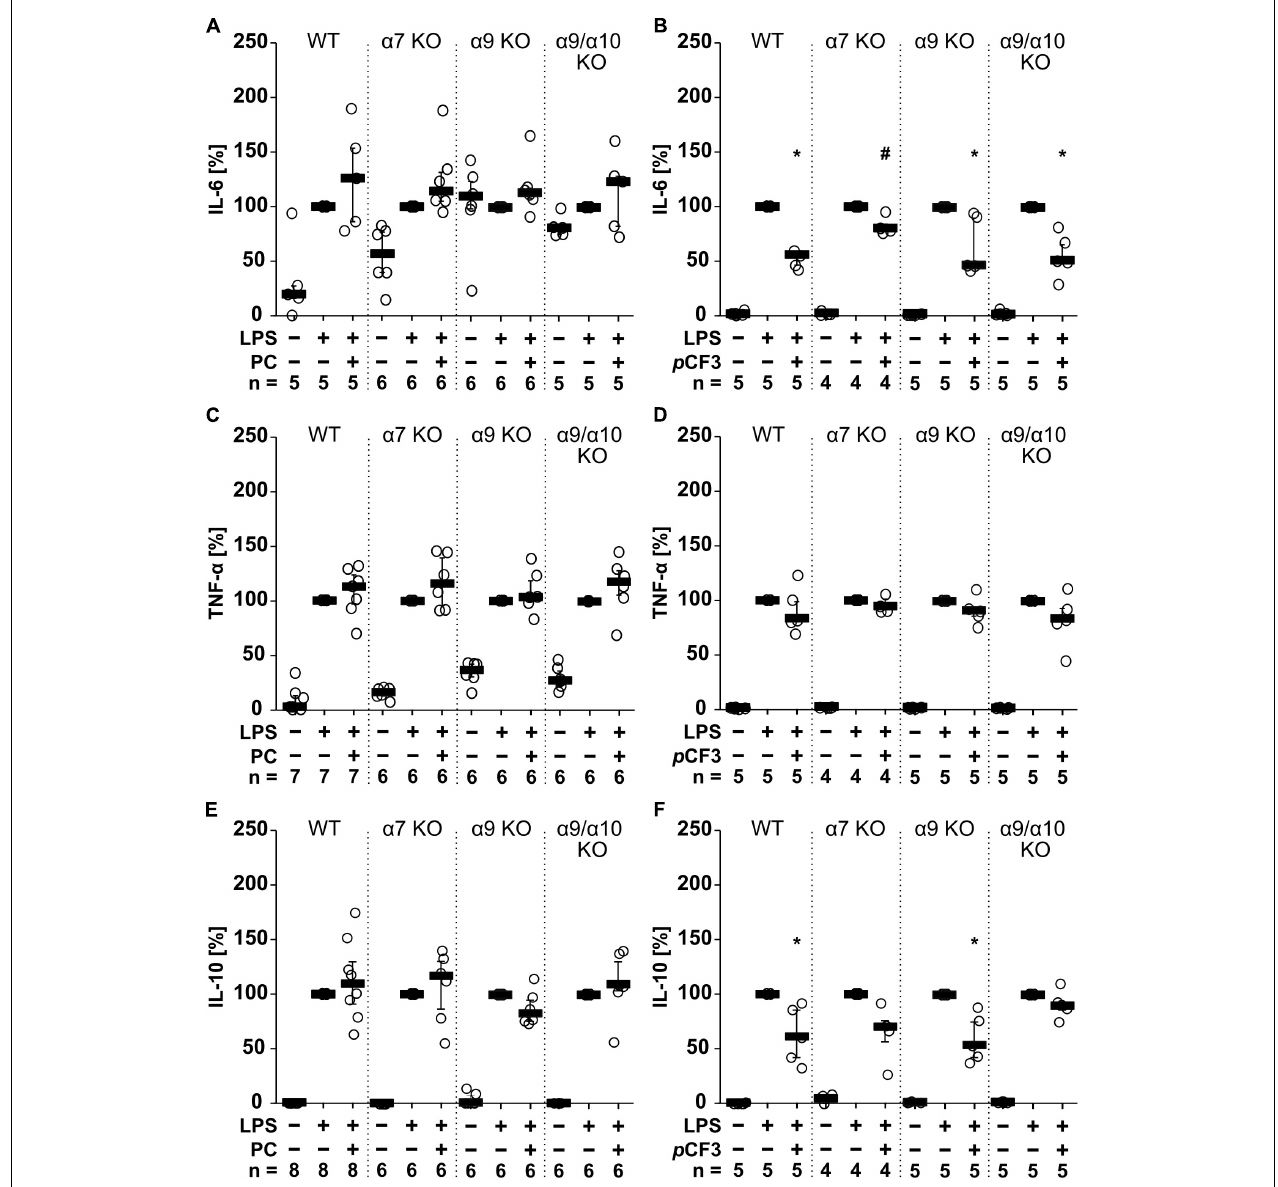
FIGURE 1 | The effect of phosphocholine (PC) and p CF3-diEPP ( p CF3) on lipopolysaccharide (LPS)-mediated cytokine release by mouse bone marrow-derived macrophages (BMDMs). BMDMs were isolated and cultured from wild-type (WT) and mice gene-deficient in Chrna 7 ( α 7 KO), Chrna 9 ( α 9 KO) or Chrna 9 and Chrna 10 ( α 9/ α 10 KO). On day 6 of cultivation, BMDMs were primed with lipopolysaccharide (LPS; 1 µ g/ml; 5 h) in the absence and presence of PC (100 µ M) or p CF3 (100 µ M). The LPS-induced release of (A,B) interleukin-6 (IL-6), (C,D) tumor necrosis factor- α (TNF- α ) and (E,F) IL-10 were measured in cell free cell culture supernatants by BD Cytometric Bead Arrays. Cytokine levels obtained after stimulation with LPS alone, were set to 100%, and all other values were calculated accordingly. Data are presented as individual data points, bars represent median, whiskers encompass the 25 th to 75 th percentile. * p ≤ 0.05, different from cells stimulated with LPS alone, Friedman-test followed by the Wilcoxon signed-rank test. # p ≤ 0.05, significantly different from the same condition in WT, Kruskal–Wallis followed by Mann–Whitney rank sum